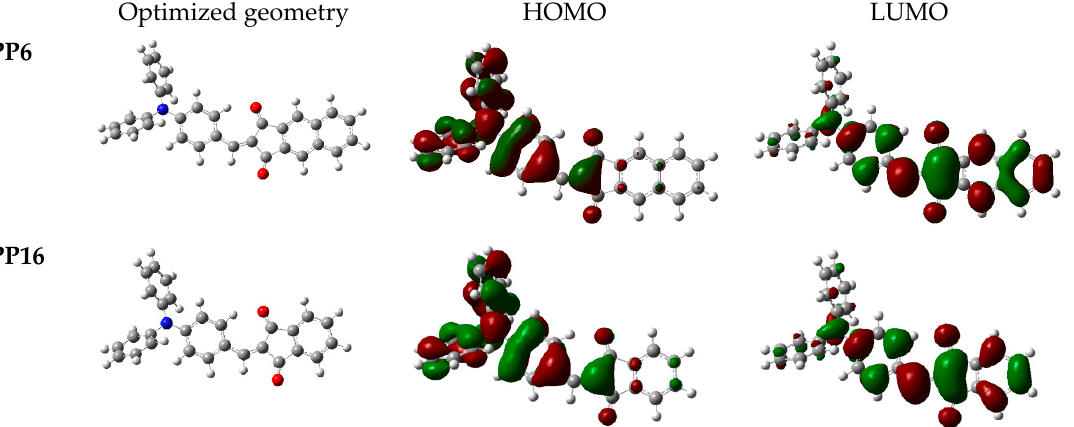
/ LUMO electronic distributions of PP6 and PP16 Figure 5. Optimized geometries and HOMO/LUMO electronic distributions of PP6 and PP16 . Figure 5. Optimized geometries and HOMO